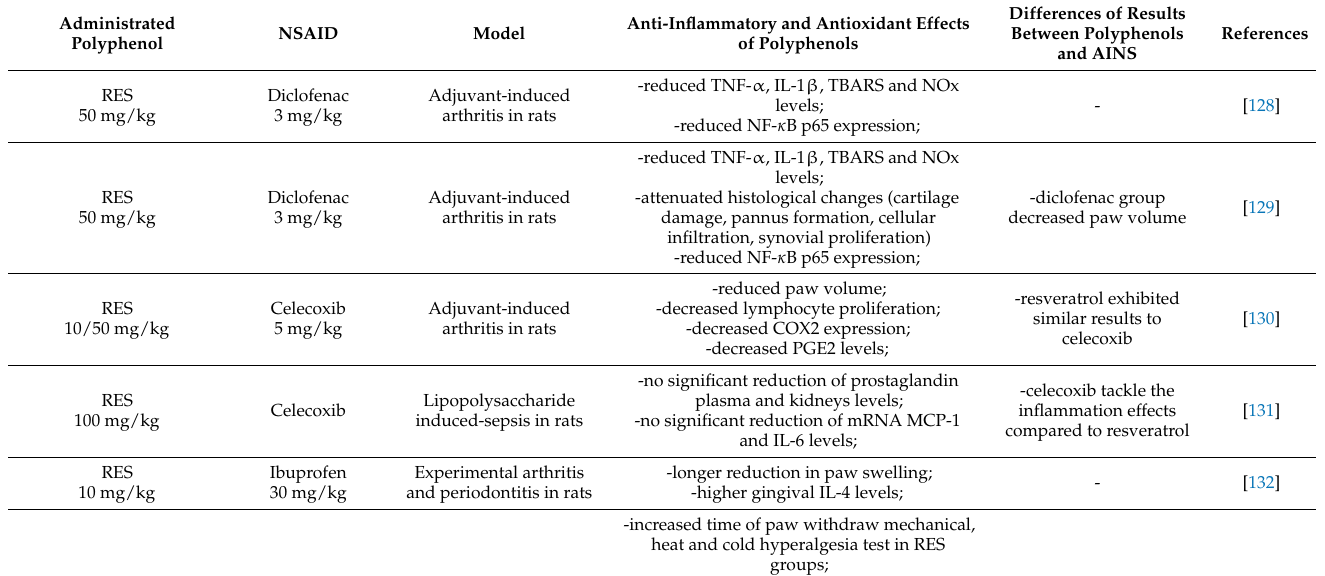
Table 3. Grape pomace polyphenols versus non-steroidal anti-inflammatory drugs in oxidative stress and